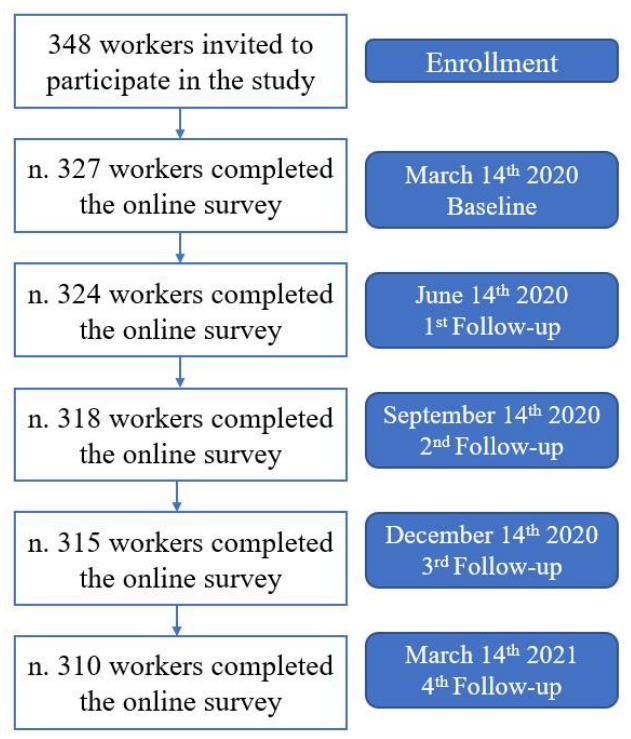
Figure 1. Baseline and follow-up flow chart.